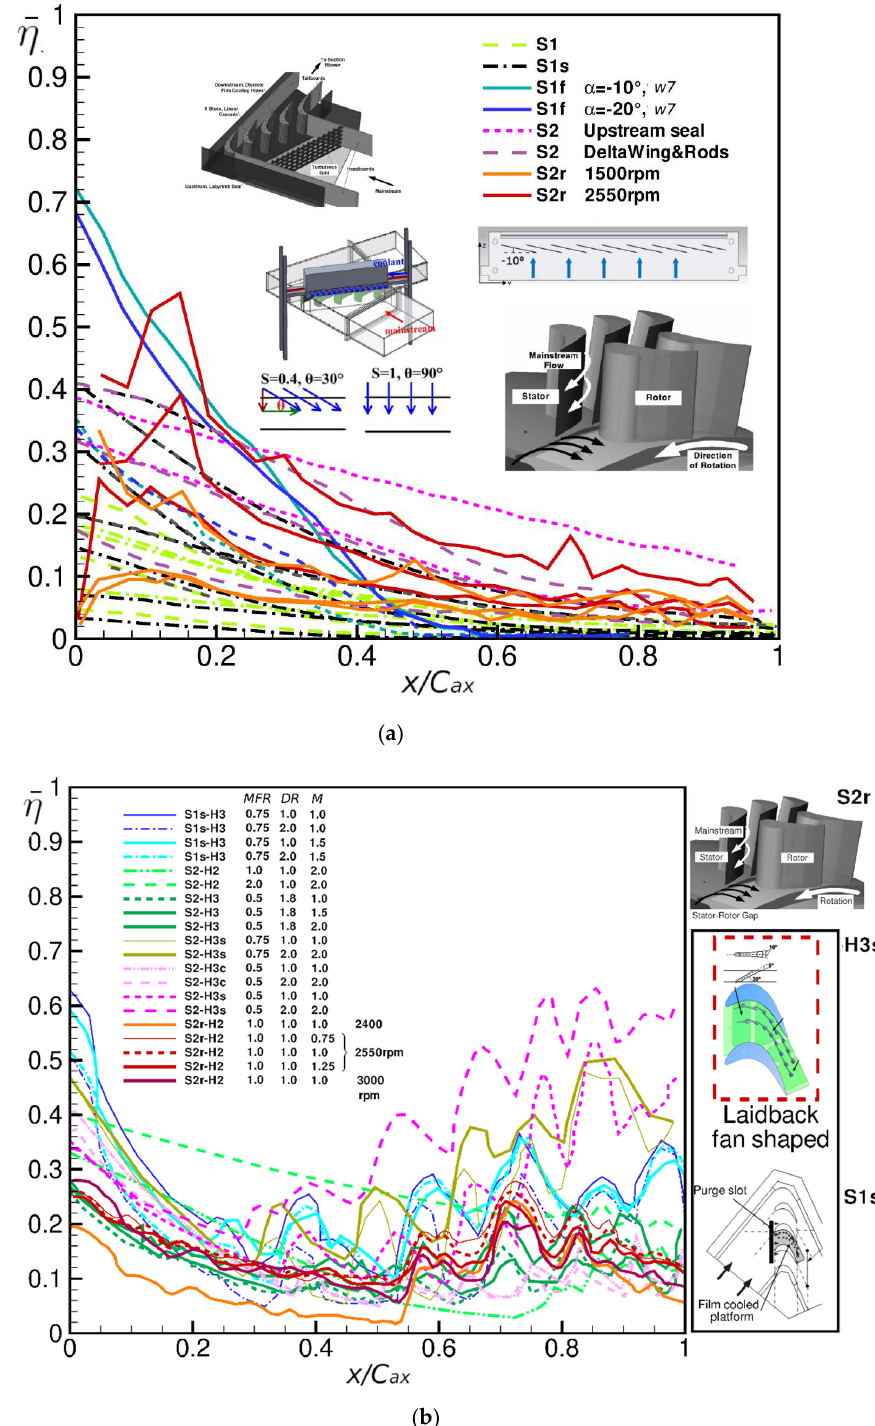
Figure 8. Rotor platform film cooling effectiveness: ( a ) purge flow only, S1, S1s [18], S1f [22], [S2]- magenta line [19], S2 purple line [20], S2r [29] and ( b ) purge flow and discrete holes presented in the open literature S1s-H3 [16], S2-H2 [19], S2-H3 [15], S2-H3c/s [14], S2r-H2 [30]. To allow a better comparison between different gap geometries, Figure 9 shows some of the data reported in Figure 8a evidencing the operating conditions (coolant to mainstream mass flow ratio, turbulence intensity, swirling condition). In particular, for consistency, only data coming from [18] have been used to create Figure 9, since the campaign of [18] constitutes quite a complete set. These data support the general conclusion that increasing MFR and Tu % both result into an improvement in effectiveness, both in terms of η level and persistency going downstream. Conversely, a stronger swirl always translates into an effectiveness reduction, that gets stronger at high injection rates. Finally, please note that the reported distributions only extend over the blade passage. This means that the low effectiveness values at x/C ax = 0 probably depend on the gap to leading edge distance of this specific solution, which was not, unfortunately, reported in the original paper [18].